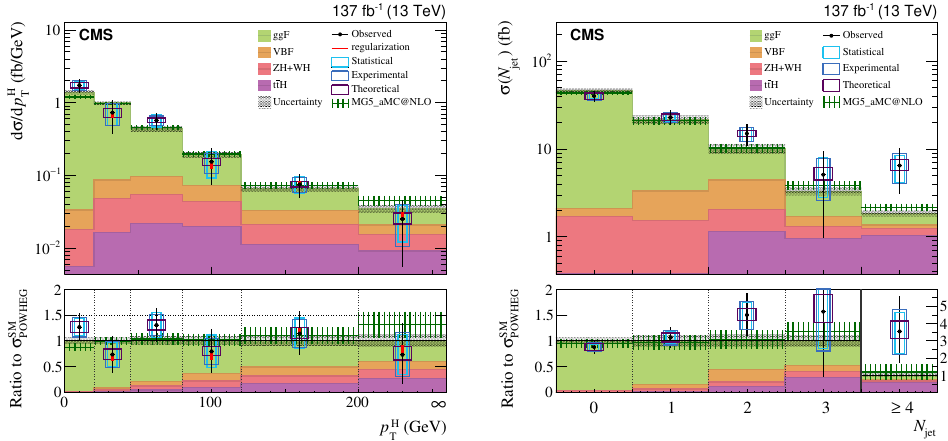
Figure 4 . Observed fiducial cross sections in bins of p H (left) and N (right), overlaid with predic- jet T tions from the nominal and alternative models for signal. The ggF and VBF samples are generated using powheg in the nominal model and MadGraph 5_a mc@nlo in the alternative model. The uncertainty bars on the observed cross sections represent the total uncertainty, with the statisti- cal, experimental (including luminosity), and theoretical uncertainties also shown separately. The uncertainty bands on the theoretical predictions correspond to quadratic sums of renormalization- and factorization-scale uncertainties, PDF uncertainties, and statistical uncertainties of the simu- lation. The filled histograms in the ratio plots show the relative contributions of the Higgs boson production modes in each